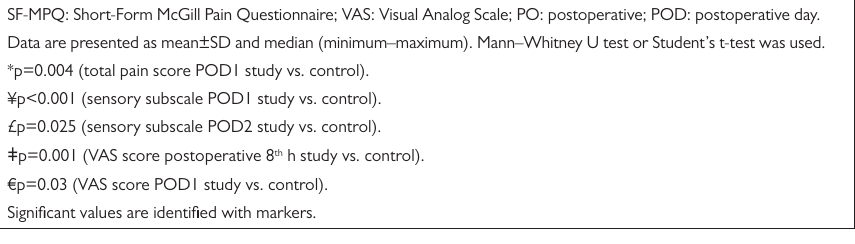
Symptom Distress Scale